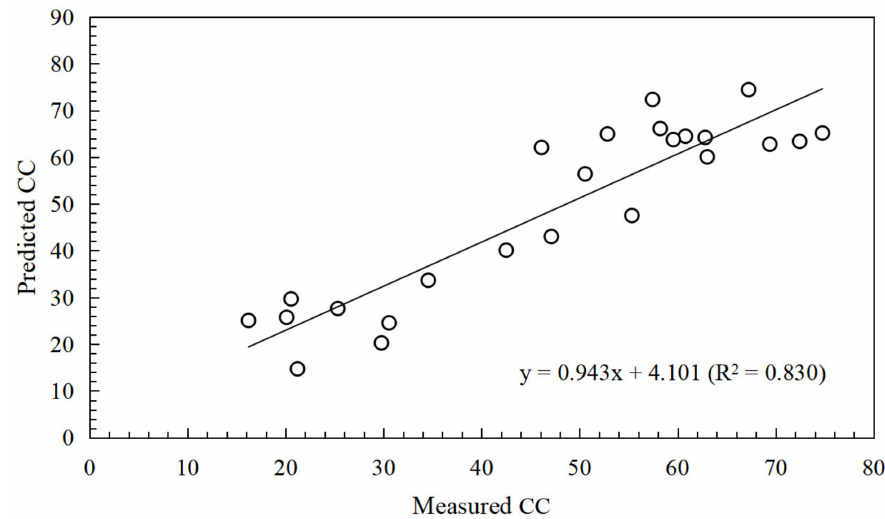
Figure 10. Agreement between the predicted CC from the Landsat-derived CC map and the indepen- dent group of 24 validation plots of CC from Google